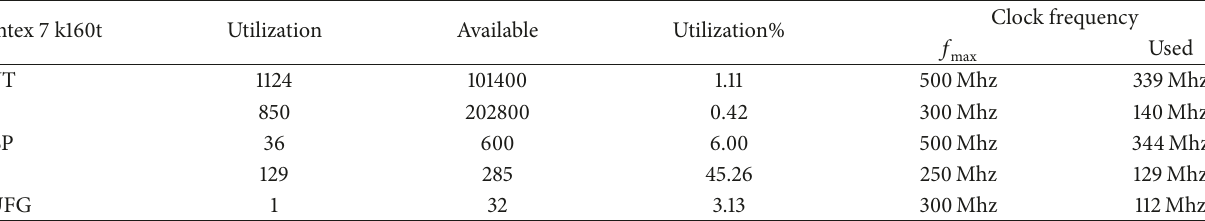
Figure 16: (a) Power utilized by FOSG system. (b) Power utilized for various fractional orders. Table 3: Resource utilization of GAFOPID